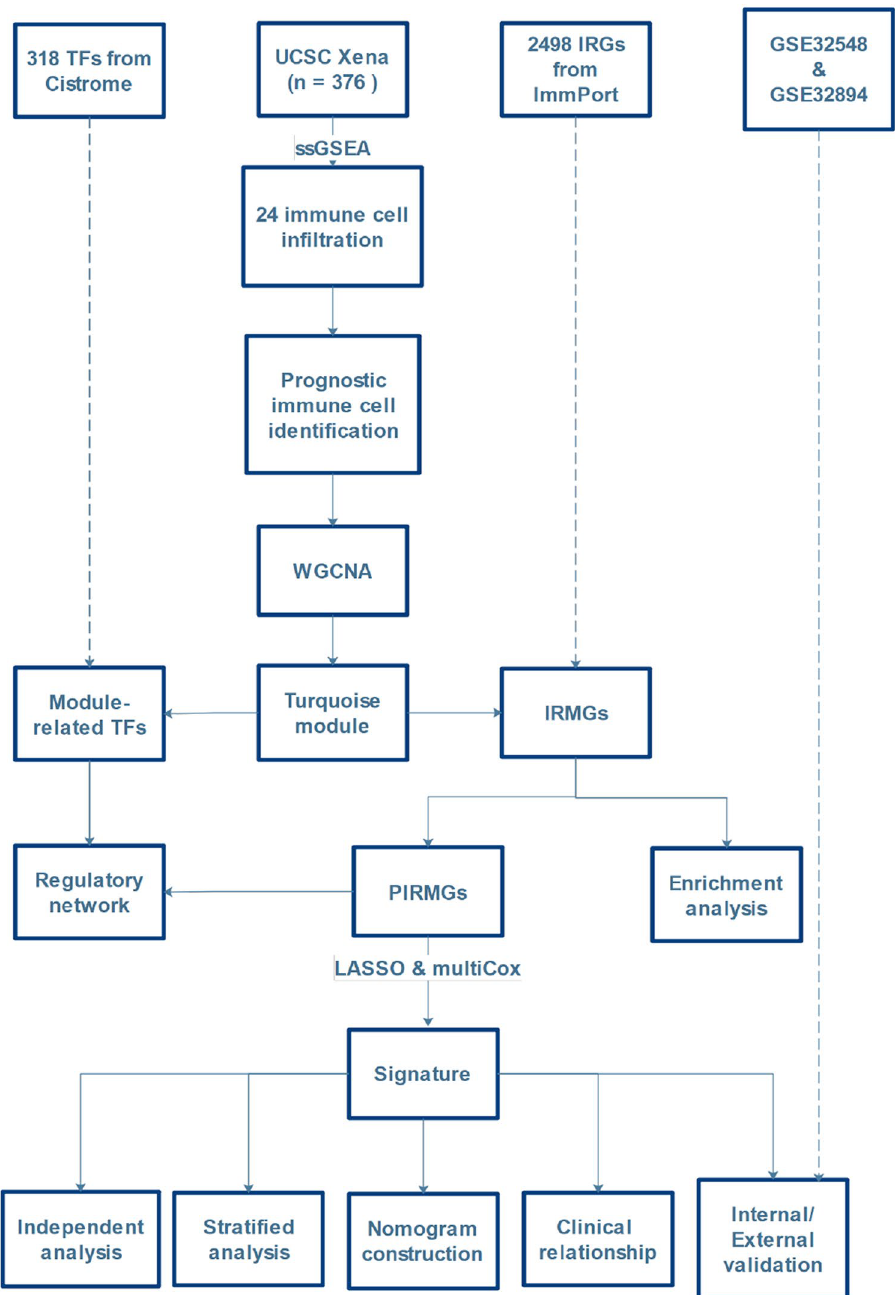
Figure 8. Work flow of this study. TF transcription factors, IRG immune-related gene, ssGSEA single sample gene set enrichment analysis, WGCNA weighted correlation network analysis, IRMG immune-related module gene, PIRMG prognostic IRMG, LASSO Least Absolute Shrinkage and Selector Operation, multiCox multivariate